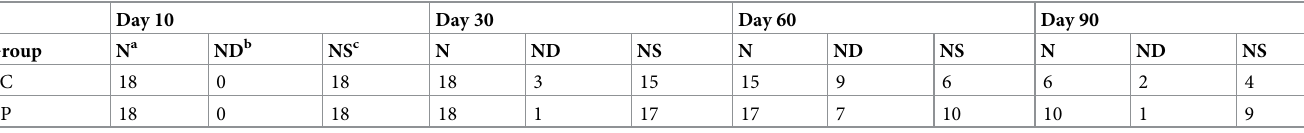
Table 3. Death of mice in each group.